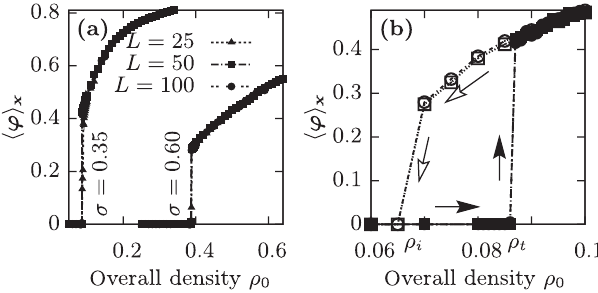
FIG. 3. (a) Average momentum against density ρ for two noise levels σ ¼ σ 0 and three system sizes L ; specific values are 5 ). The results indicate that the indicated in the figure ( ϵ x ¼ transition is first order. (b) Hysteresis study. The average momentum against overall density ρ 0 for σ ¼ σ 0 ¼ 0 . 35 and two system sizes L ∈ f 50 ; 100 g . Solid symbols (with the paths indicated by solid arrows) indicate the system ’ s stationary state when starting from random initial conditions. Open symbols (with the paths indicated by open arrows) indicate the system ’ s stationary states upon lowering the density quasistatically starting from a stationary wavelike pattern at ρ 0 > ρ . The system exhibits t hysteresis, corroborating the assertion that the underlying order- ing transition is first